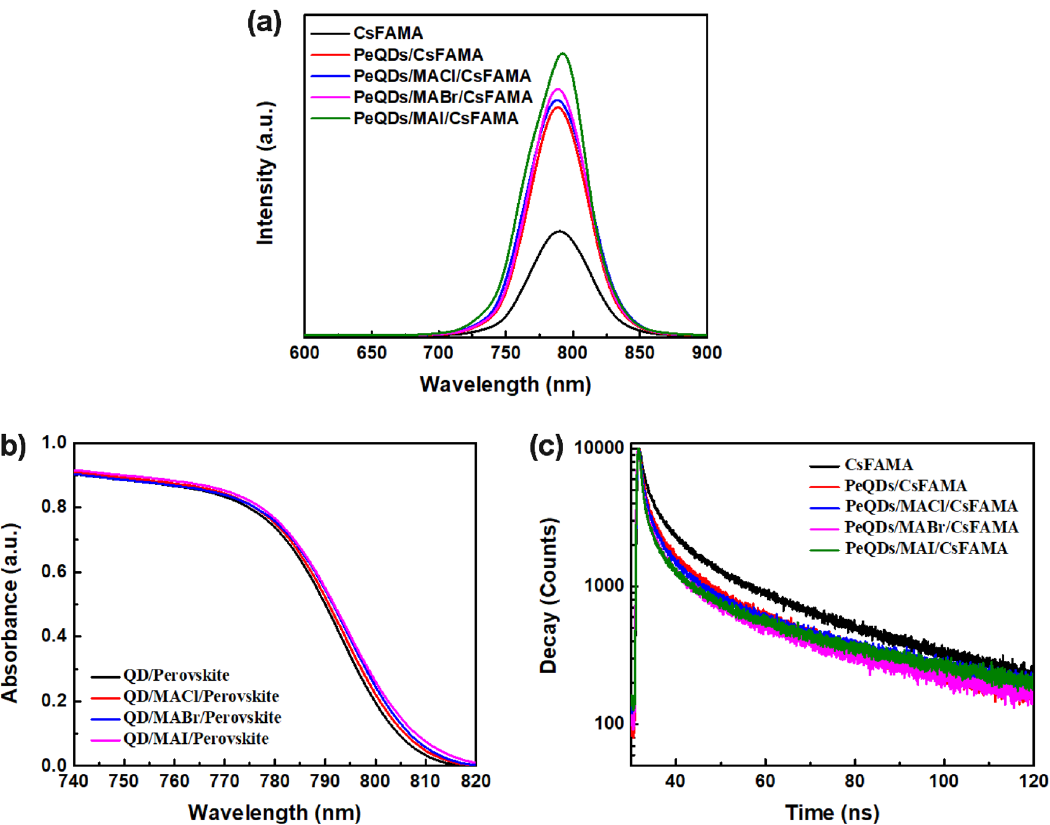
Figure 5. ( a ) Photoluminescence (PL), ( b ) absorption spectra, and ( c ) Time-resolved PL decay curves of the CsFAMA, PeQDs/CsFAMA, and PeQDs/MAX (Cl, Br, I)/CsFAMA perovskite films.